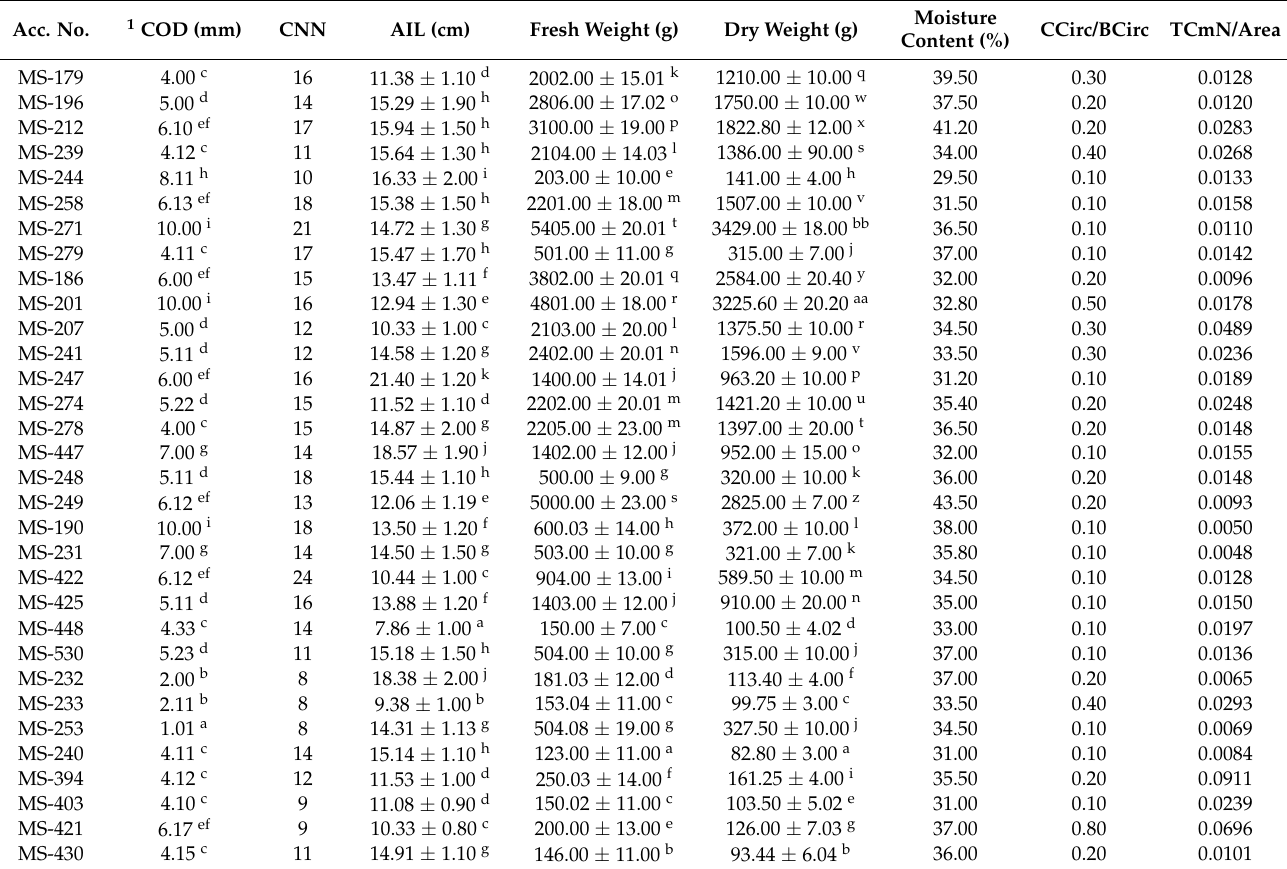
Table 3. Morphological characteristics of the selected M. sacchariflorus